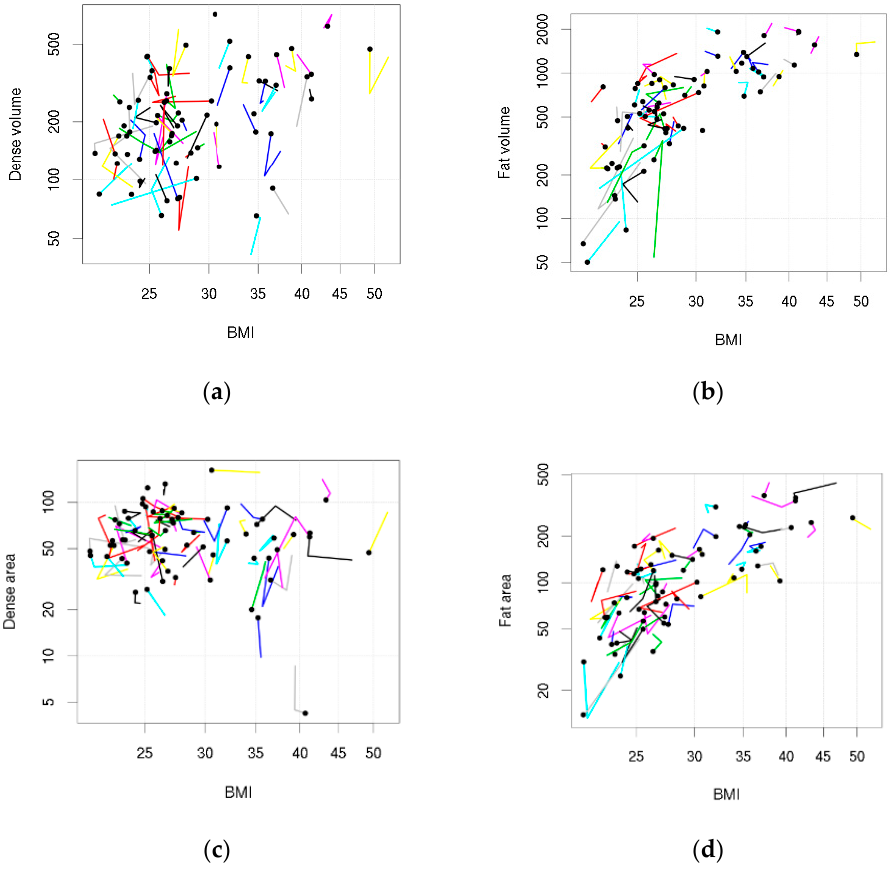
Figure 1. Tadpole plots showing body mass index (BMI) and density measures across the 2 year follow-up. Each tadpole represents a woman: the tadpole head shows BMI and density (if density is available) at her last follow-up and the points on the tail show BMI and density (if density is available) at her earlier follow-ups. ( a ) Dense volume; ( b ) Fat volume; ( c ) Dense area; ( d ) Fat area.